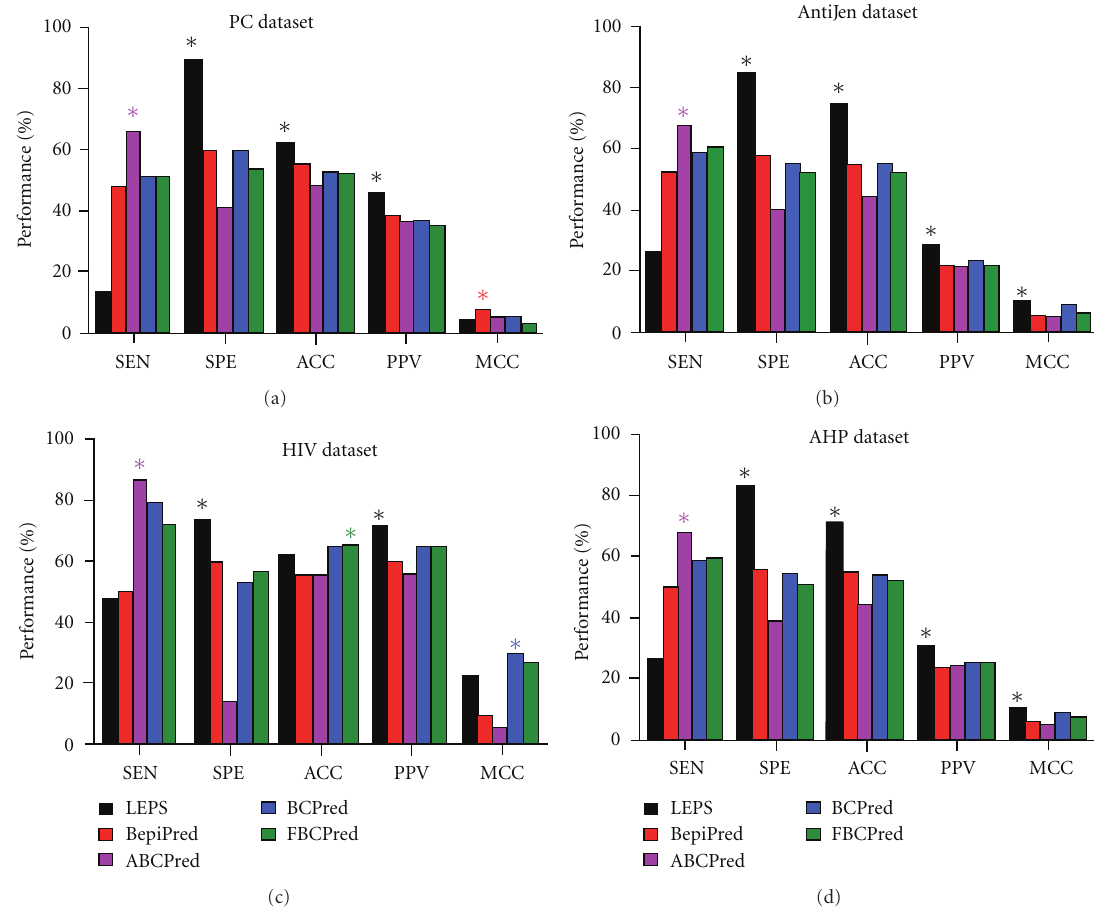
Figure 2: Comparison of the performances of LEPS, BepiPred, ABCPred, BCPred, and FBCPred systems. The best performance for each indicator is marked with a